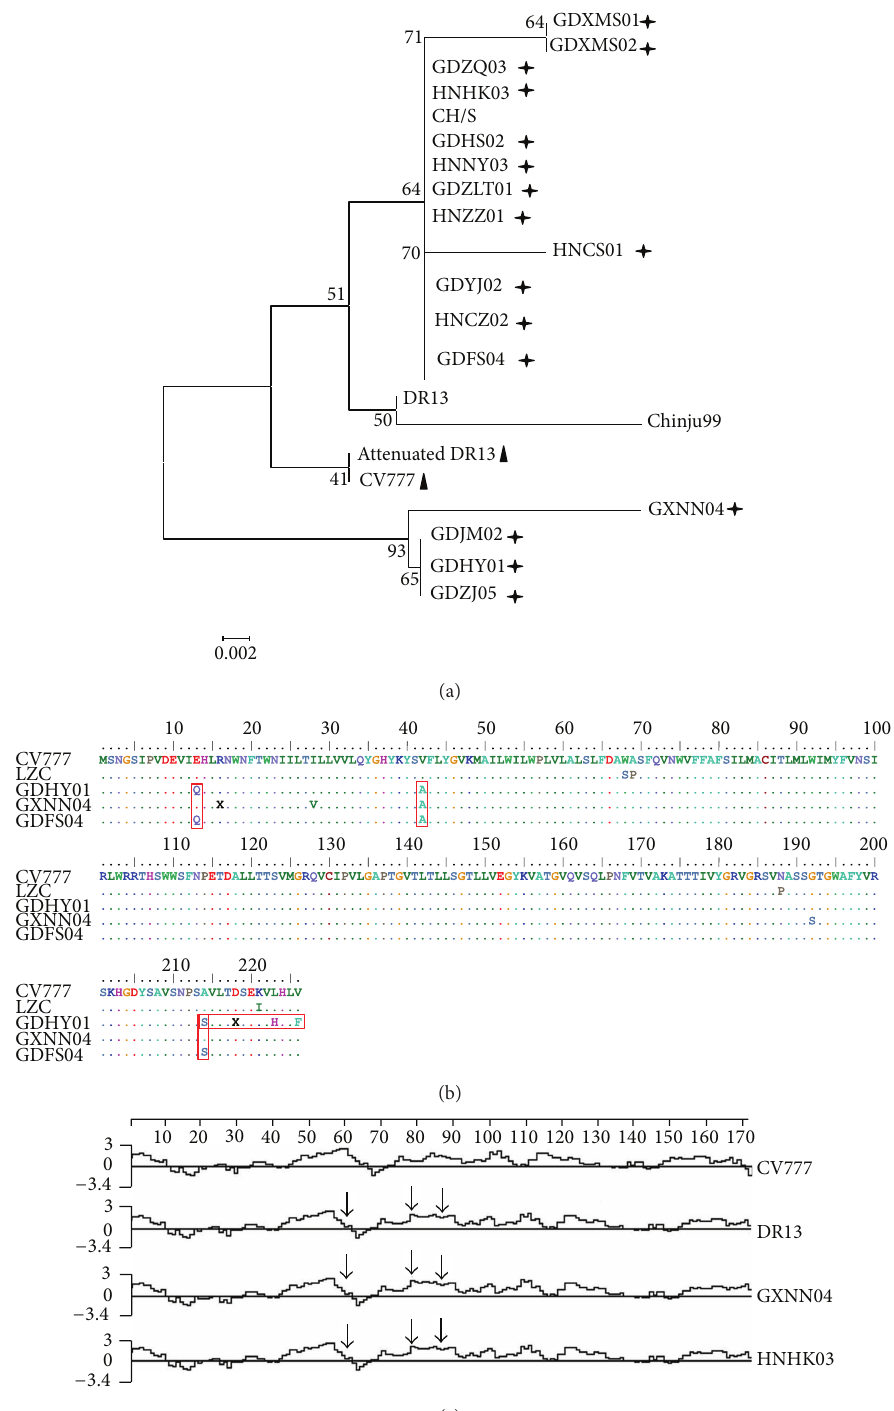
Figure 2: Comprehensive analysis of ORF3 genes from current PEDV with reference strains. (a) Phylogenetic analysis based on ORF3 aa; (b) point mutations analysis of ORF3 aa; (c) hydrophobic analysis of S aa. Phylogenetic tree is constructed by the neighbor-joining method with the MEGA 4.0 program. The percentage bootstrap support (per 1000 replicates) is indicated by the values at each node. Cross asterisk indicated present isolates; triangle indicated attenuated strains; box indicated point